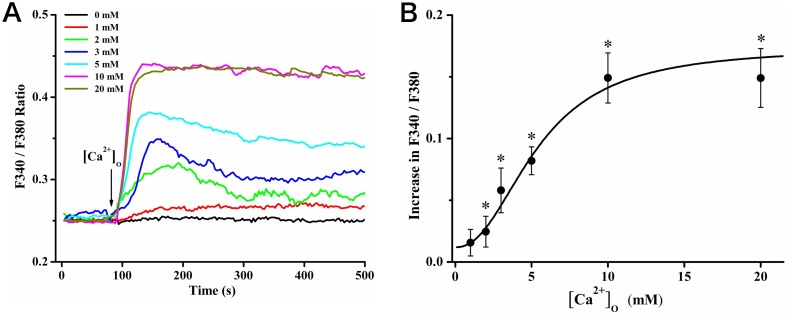
Elevated [Ca2+]o resulted in [Ca2+]c increases in rat calvarial osteoblasts.(A) Representative tracings of [Ca2+]c responses induced by [Ca2+]o at 0, 1, 2, 3, 5, 10 and 20 mM, respectively. (B) The statistic peak values of increase in F340/F380 ratio were plotted against [Ca2+]o (n = 15 for each case), * showed P<0.05. The smooth curve represented the fitting to the equation of  with an EC50 value of 5.4±1.2 mM and Hill coefficient (n) of 2.2